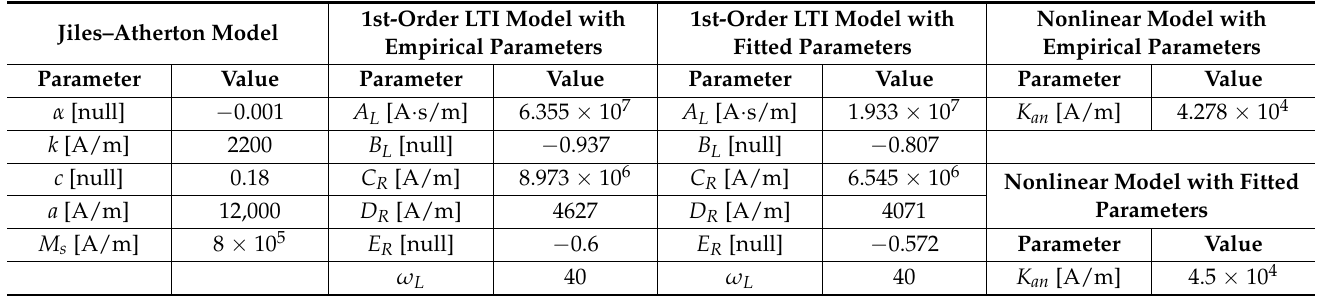
Table 2. Parameters of the giant magnetostrictive material from various models or accessing ways.